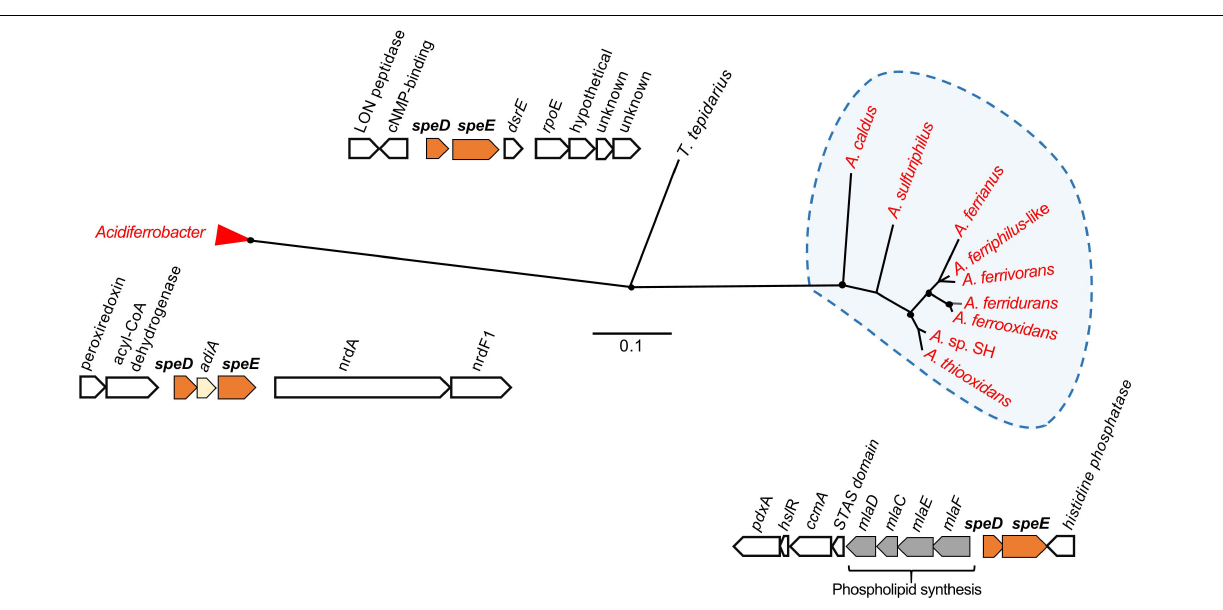
FIGURE 4 | Unrooted phylogenetic tree of concatenated amino acid sequences of spe D and spe E in the Acidithiobacillia and their best hits in the NCBI databases. Acidithiobacillaceae sequences group in a clade from neutrophilic T. tepidarius , and had highest similarity to homologs in extreme acidophiles of the Acidiferrobacter group. Acidophilic sequences are highlighted in red. Filled circles at the nodes indicate bootstrap support ≥ 60%. The scale bar represents 0.1 amino acid substitution per